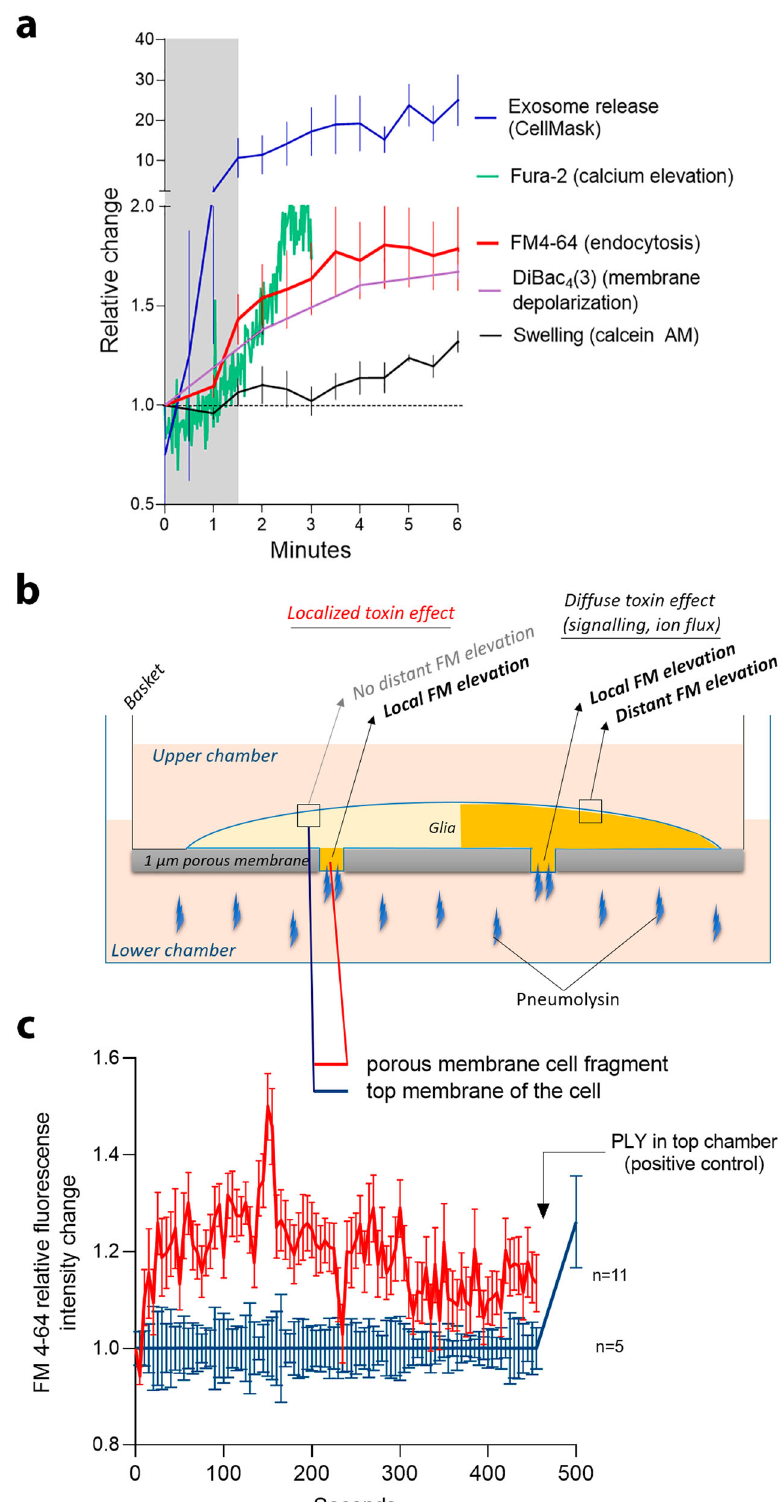
Fig. 7 | Temporospatial features of endocytosis enhancement after challenge withrecombinant PLY.a Time frame ofendocytosischange(FM4-64,normalized totimepoint0, n =6independentexperiments),exosomerelease(CellMask,single vesicles counted, n =4 independent experiments), membrane depolarization (DiBac 4 (3), fl uorescence increase, normalized to timepoint 0 and to mock, n =15 cells),calciumincrease(Fura-2,ratiometricvalue,increasingwithcalciumincrease, n =4 independent experiments), and cell swelling (calcein AM, fl uorescence intensity inversely normalized to timepoint 0 (the value increases when swelling